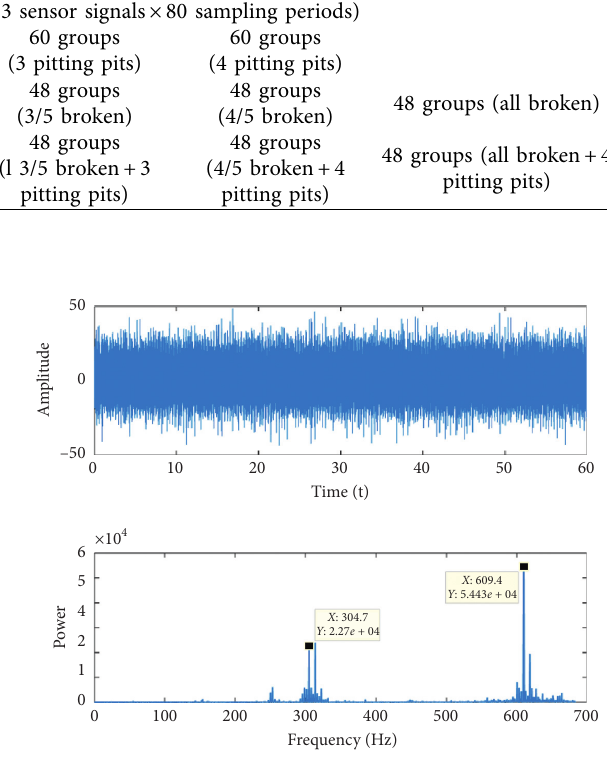
Figure 20: Time domain and frequency domain diagram for signal of broken tooth gear.